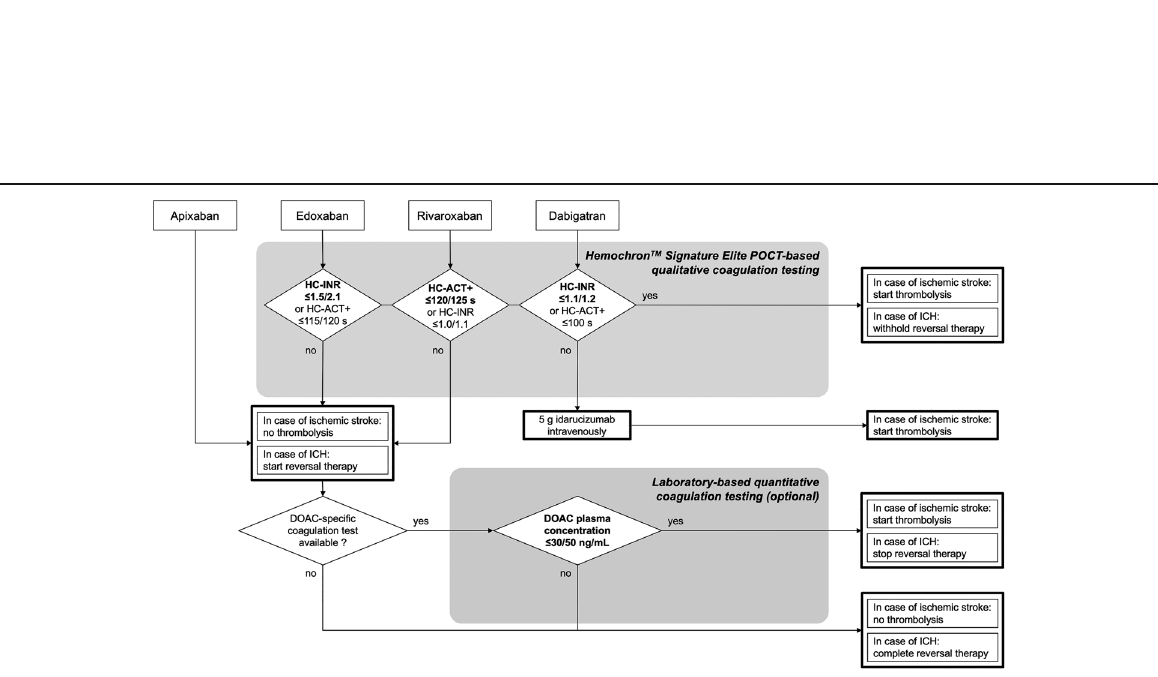
Fig. 4 Proposed algorithm for emergency coagulation assessment using the Hemochron ™ Signature Elite point-of-care test system (POCT) for rapid decision making in patients treated with direct oral anticoagulants (DOAC). Ideal assay- and DOAC-specific cut-offs are provided for the 30/ 50 ng/mL thresholds. ICH = intracranial hemorrhage; HC-INR and HC-ACT+ = Hemochron ™ Signature Elite point-of-care test system-based international normalized ratio and activated clotting